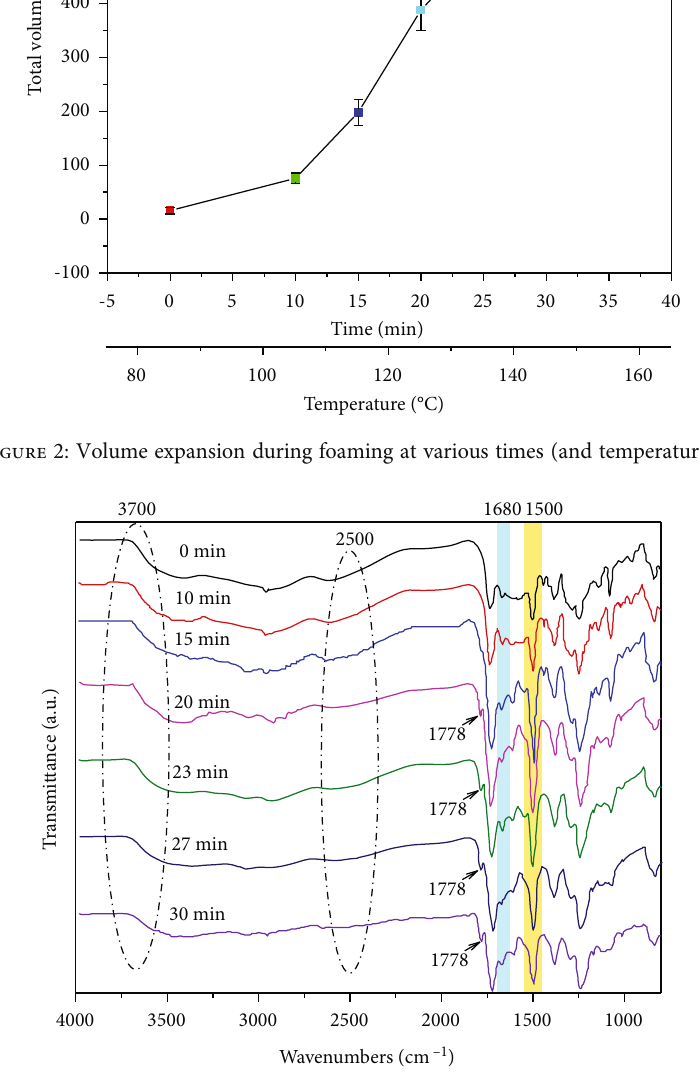
Figure 3: FTIR spectrum of PEAS foaming (150 ° C) at various